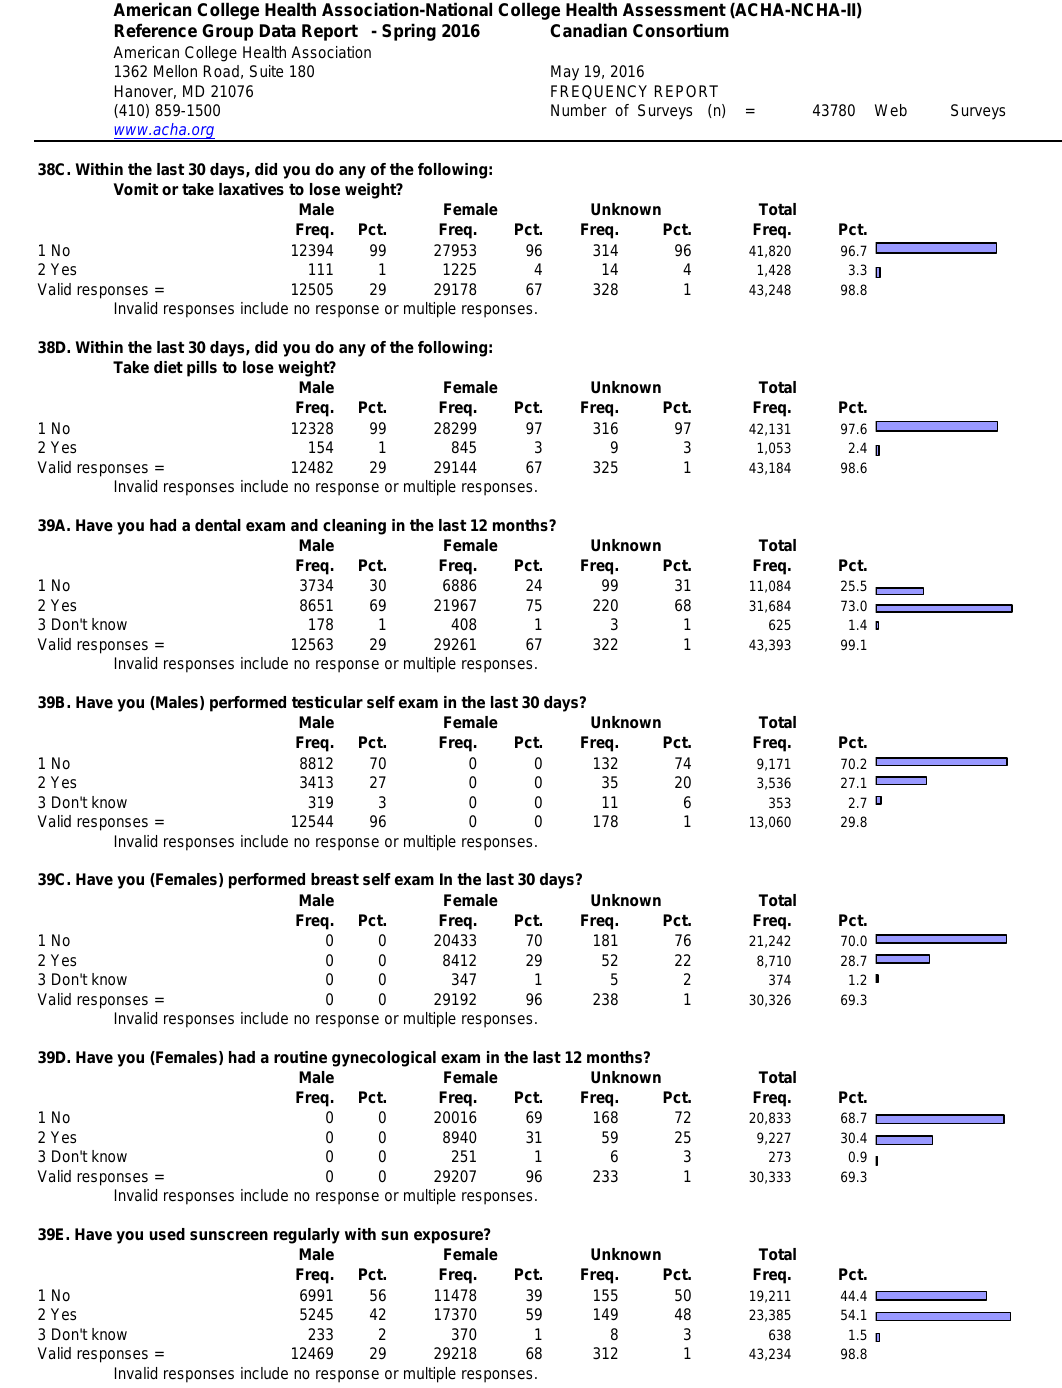
Invalid responses include no response or multiple